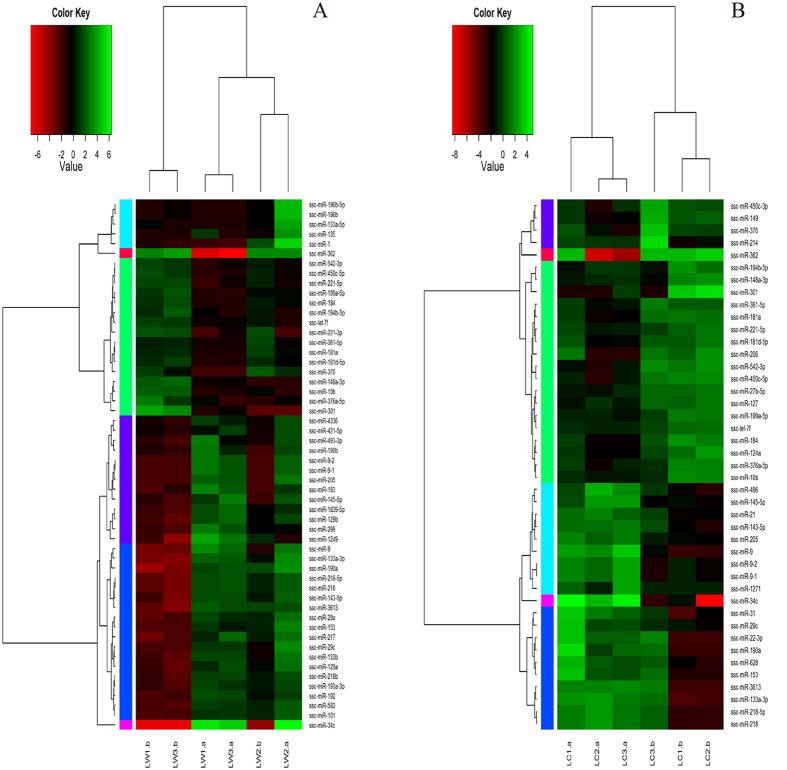
The expression of miRNAs in LW and LC pigs.(A) 54 DE miRNAs in LW pigs: 37 up-regulated expressed miRNAs and 17 down-regulated expressed. (B) 43 DE miRNAs in LC pigs: 20 up-regulated expressed miRNAs and 23 down-regulated expressed. Among these DE miRNAs, 14 were co-upexpressed and 16, meanwhile 16 were co-downexpressed.